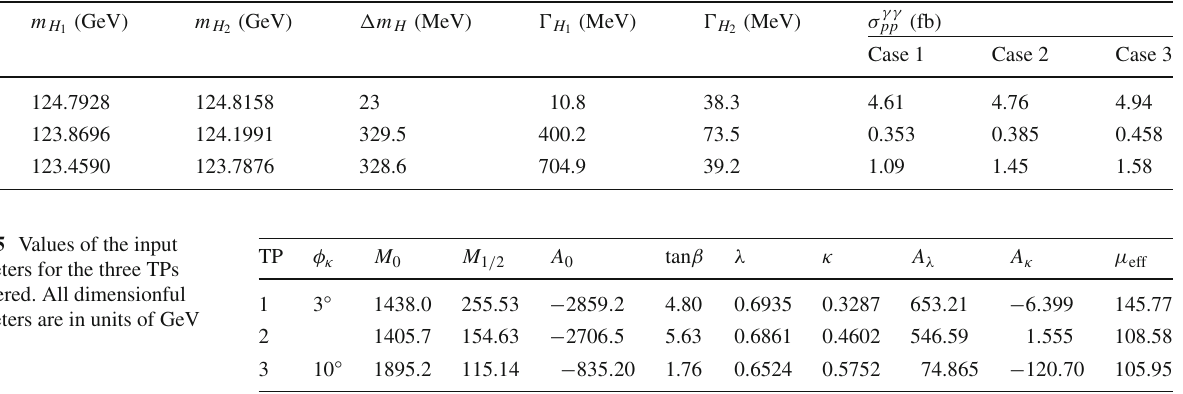
Table 4 Higgs boson masses and widths as well as the pp → H → γγ cross sections corresponding to the three Cases for the three selected TPs TP